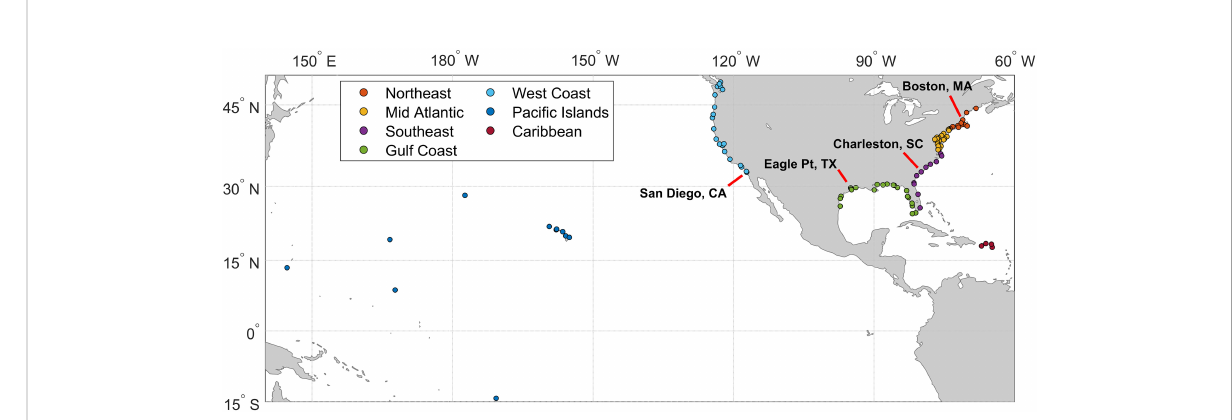
FIGURE 1 Map showing the 98 NOAA tide gauge locations used in the study color-coded by region used in the analysis (see legend). The location of four tide gauges used in detailed examples are indicated with labels and red